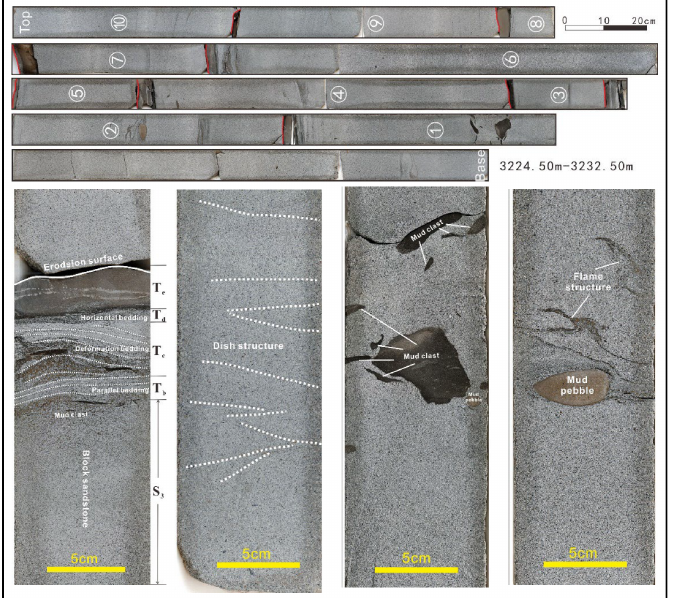
Figure 4. Photographs of gravity flow sedimentary core in well B2 (See Figure 1C for well location). ( A ) Whole cores with 10 periods of gravity flow deposition (3224.50 m–3232.50 m). ( B ) S 3 of HDTC and Bouma sequence T b-e of LDTC (3226.52 m–3226.72 m). ( C ) Dish structure (3225.2 m–3225.5 m). ( D ) Mud clasts (3230.79 m–3131.06 m). ( E ) Mud pebbles and flame structures (3229.82 m–3230.54